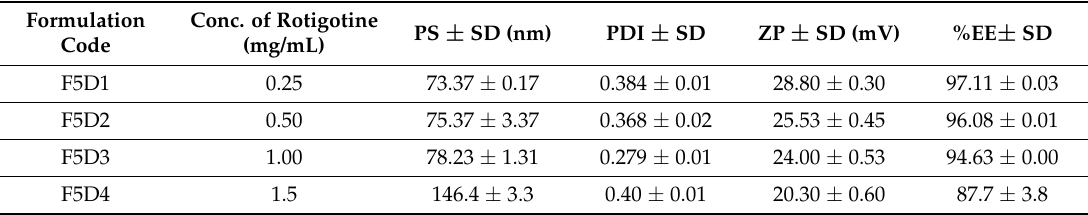
Table 3. Effect of increase in rotigotine concentration on particle size, polydispersity index, zeta potential, and entrapment efficiency ( n = 3).